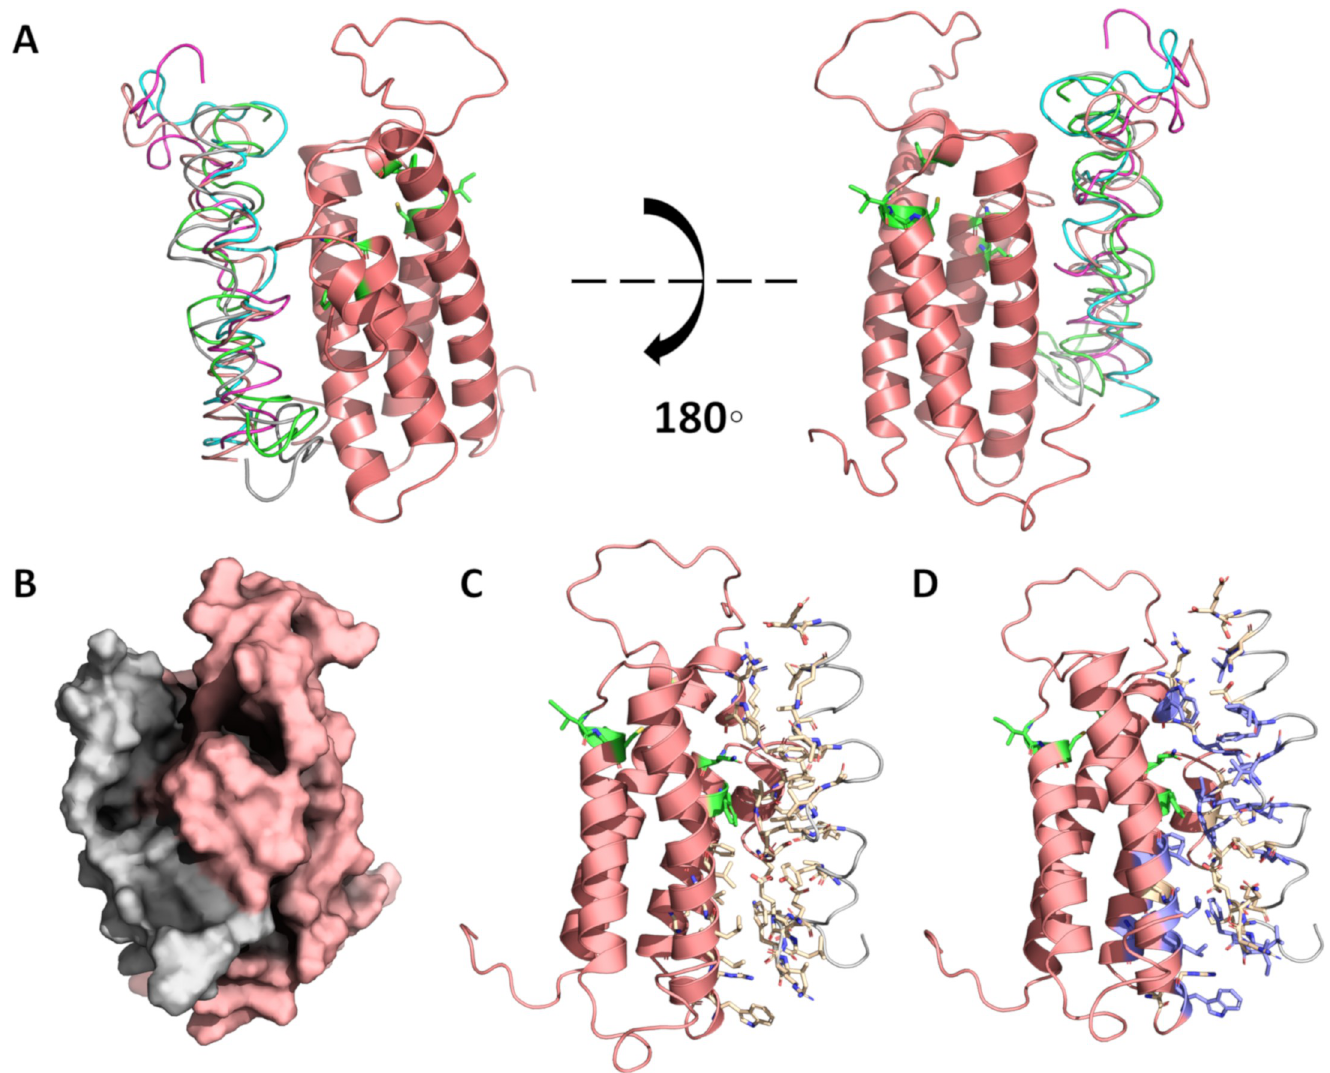
Fig 2. Predicted dock of VKORC1 and ORF7a transmembrane domain. A. Five protein-protein docks depict one main binding site (teal, grey, yellow, green, blue). B. The lowest interface-energy model is shown as a surface representation. C. The lowest interface-energy model, with side chains shown in wheat for amino acids at the interface. D. Another view of the lowest interface-energy model, with side chains shown in wheat at the interface and hydrophobics shown in blue. Amino acids of VKORC1 necessary for vitamin K binding (83F, 80N, 135C, 55F) or warfarin binding (134V, 133I) are given in green.